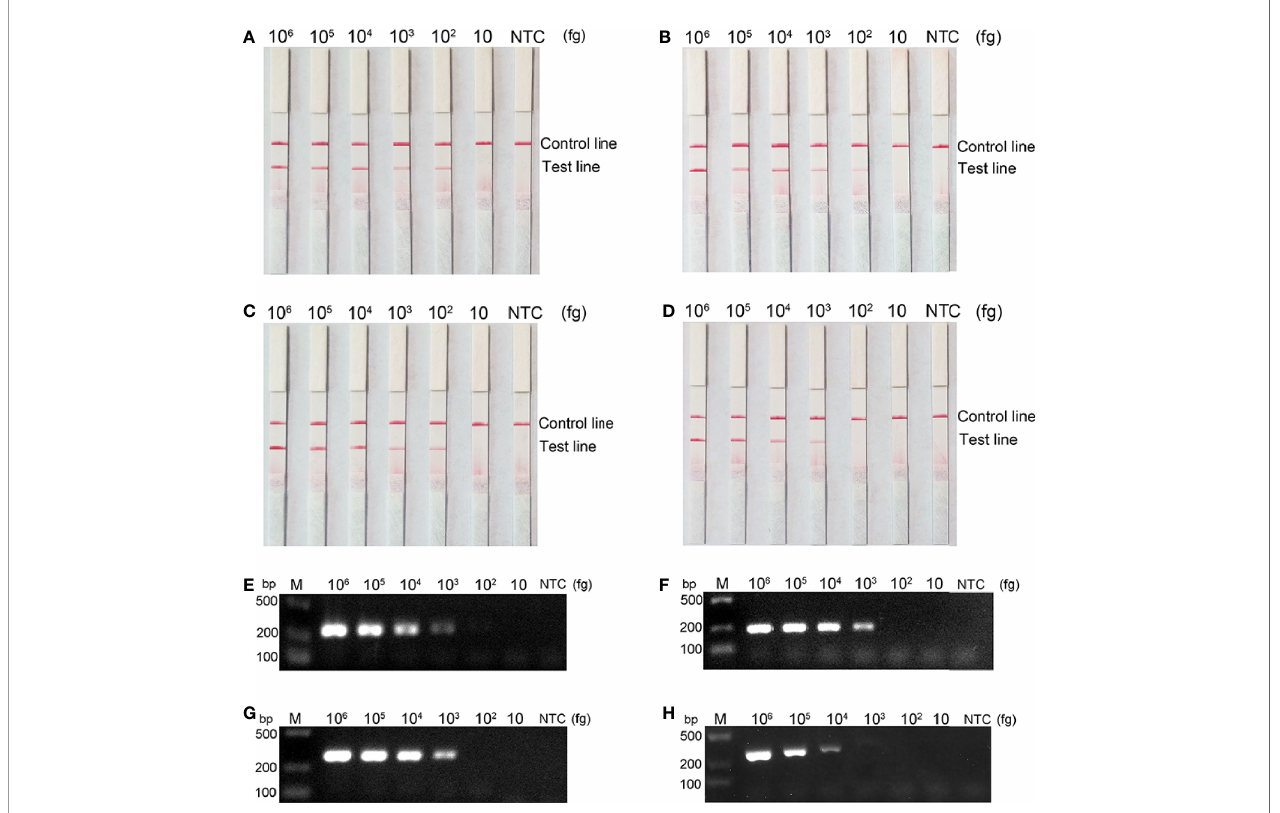
FIGURE 5 | Comparison of the sensitivity between the RPA-LFS reaction and PCR for detection of the four carbapenemase gene families. The amount of template added to each reaction is marked above the corresponding strip. (A – D) detection sensitivity of the RPA-LFS assay and (E – H) detection sensitivity of the PCR assay, representing bla KPC , bla NDM , bla OXA-48-like and bla IMP , respectively. The NTC strip is the control reaction without a template.